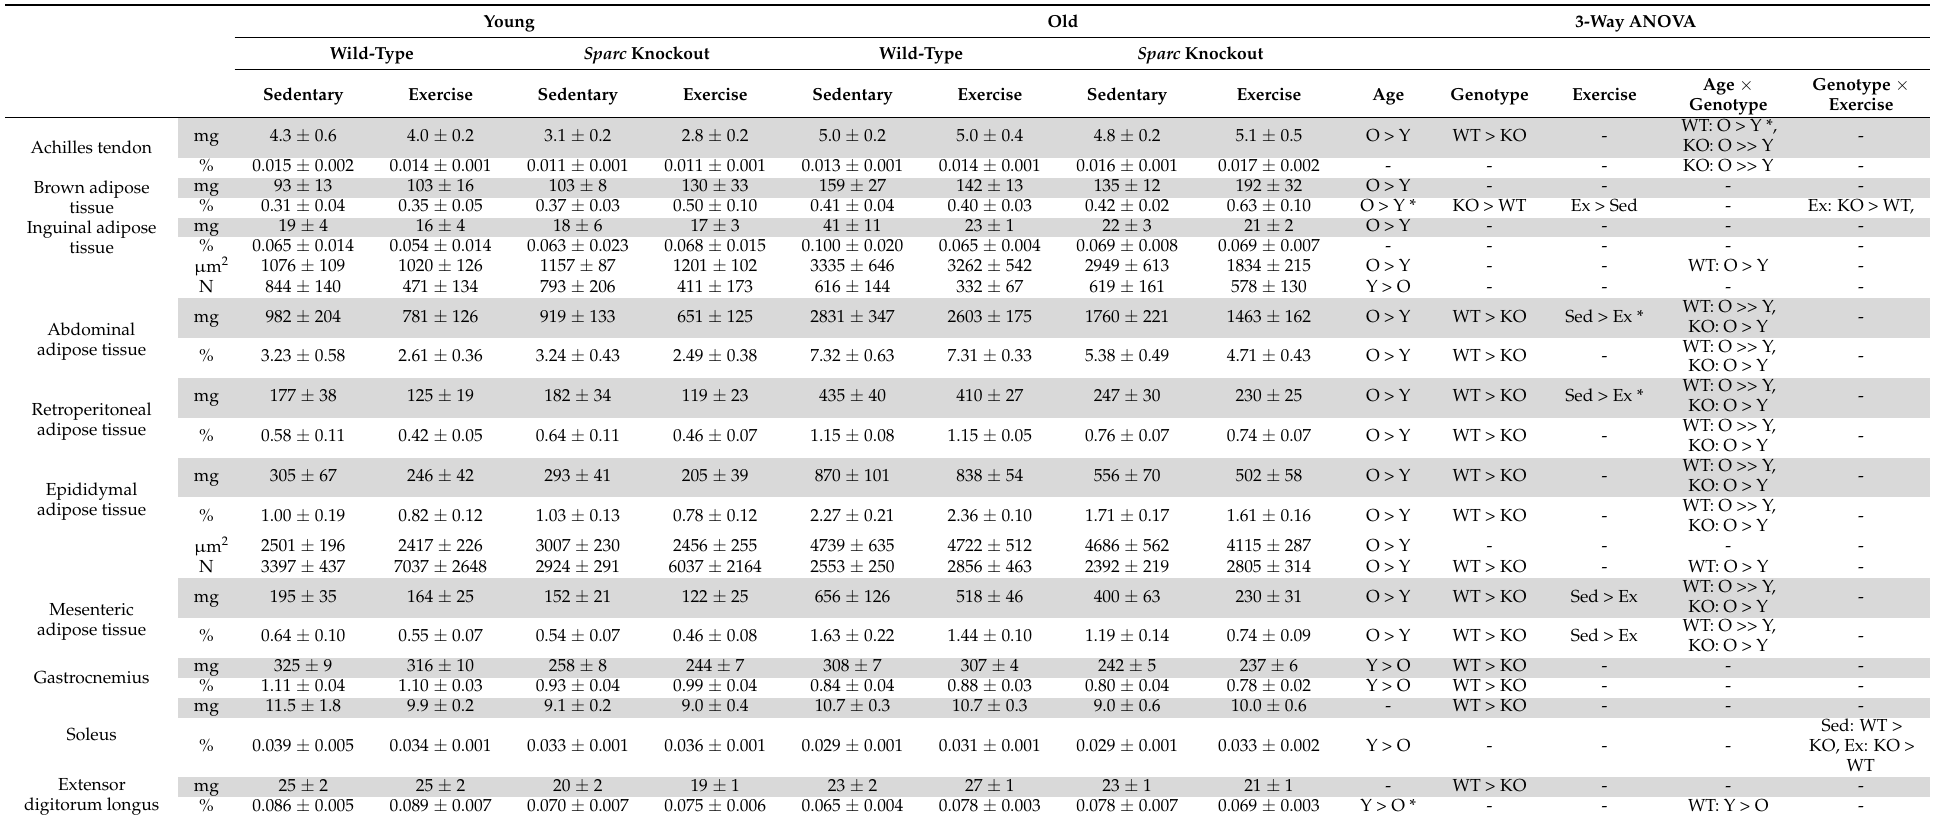
Table 1. Tissues weights and